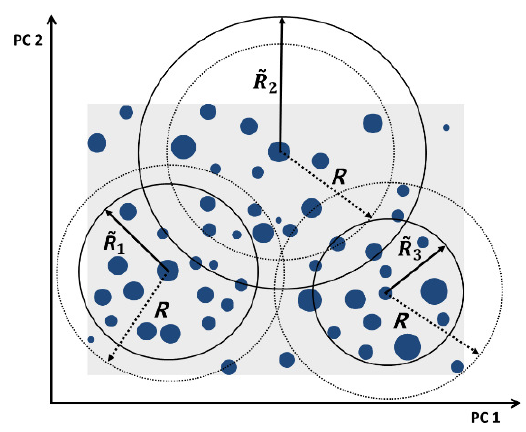
Figure 3. Grouping VMs using PCA and gravity-based